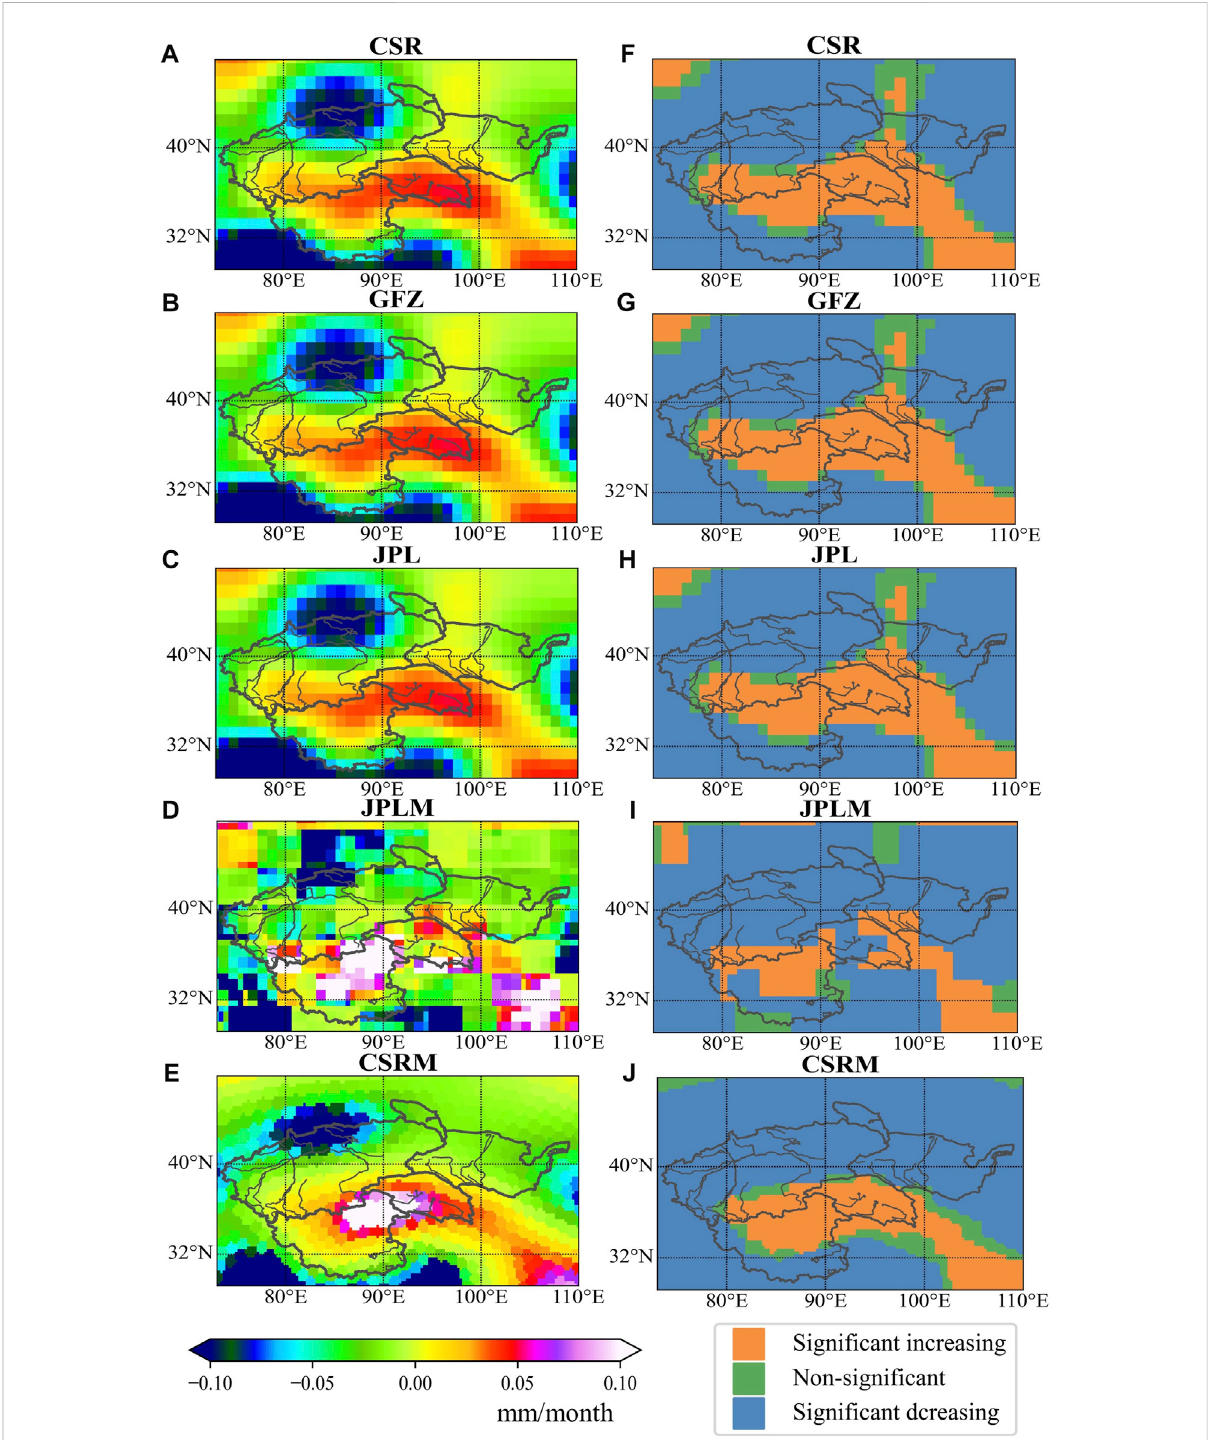
FIGURE 4 The spatial pattern of total water storage anomaly (TWSA) trends (left) and signi fi cant (right) derived from different Gravity recovery and climate experiment (GRACE) solution: TWSA trends and signi fi cant are calculated using M – K. (A,F) indicate the GRACE resolution of RL06 spherical harmonics from the Center for Space Research at the University of Texas (CSR). (B,G) indicate the GRACE resolution of RL06 spherical harmonics from the Geo-Forschungs-Zentrum in Potsdam (GFZ). (C,H) indicate the GRACE resolution of RL06 spherical harmonics from the Jet Propulsion Laboratory (JPL). (D,I) indicate the GRACE resolution of mass concentration blocks (mascons) from the JPL. (E,J) indicate the GRACE resolution of mass concentration blocks (mascons) from the